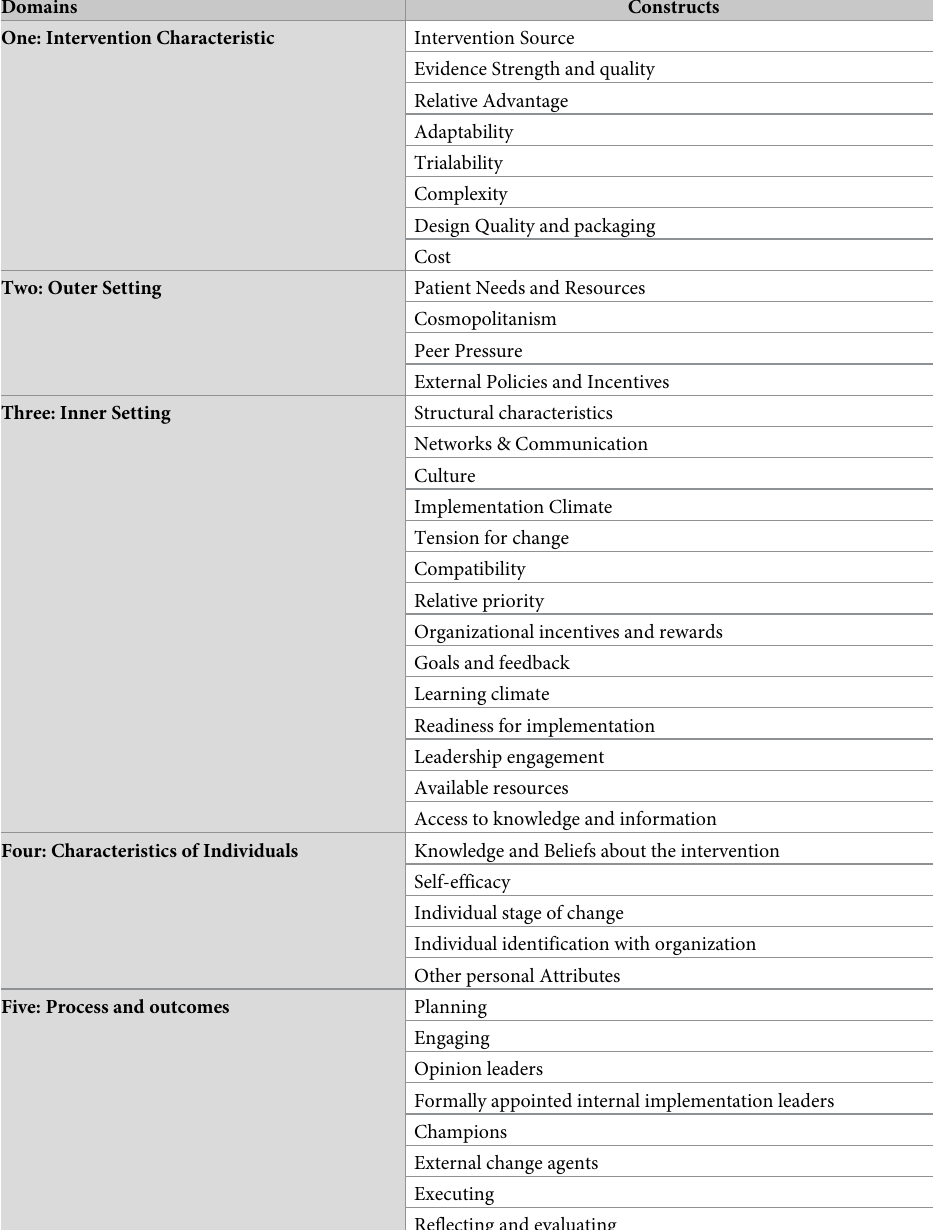
Table 1. CFIR domains and associated